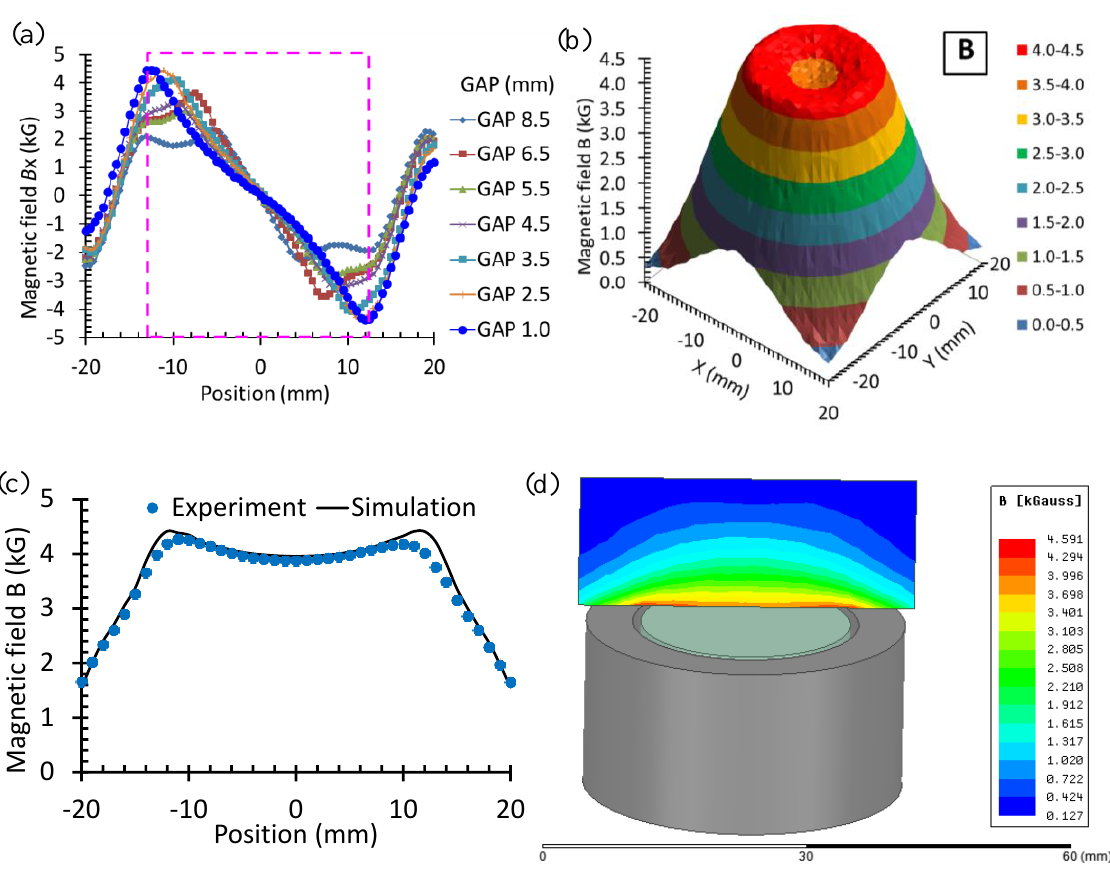
Figure 3. Magnetic field distribution at 2 mm above the magnet set of the EMAT: ( a ) The radial component B x along the x -axis for various gap sizes; ( b ) distribution of the total field B on the x – y plane for GAP = 1.0 mm; ( c ) the total field B along the x -axis obtained by measurement and simulation for GAP = 1.0 mm; and ( d ) simulation result of the total field on the central vertical plane above the magnetic set.